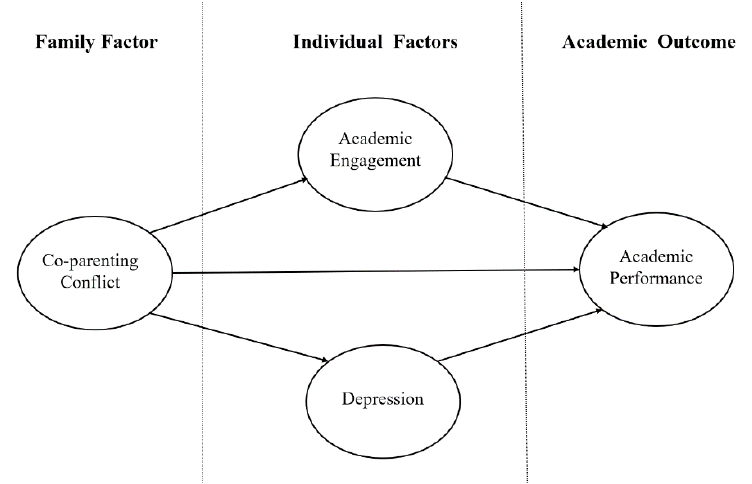
Figure 1. Hypothesized model.